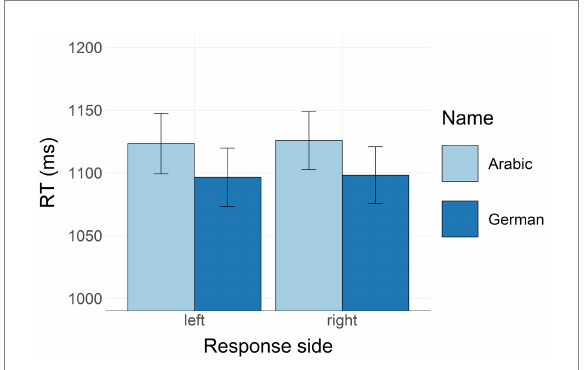
FIGURE 1 Reaction times in the SJ task aggregated by name and response side. Bars represent mean RT values. Whiskers represent standard